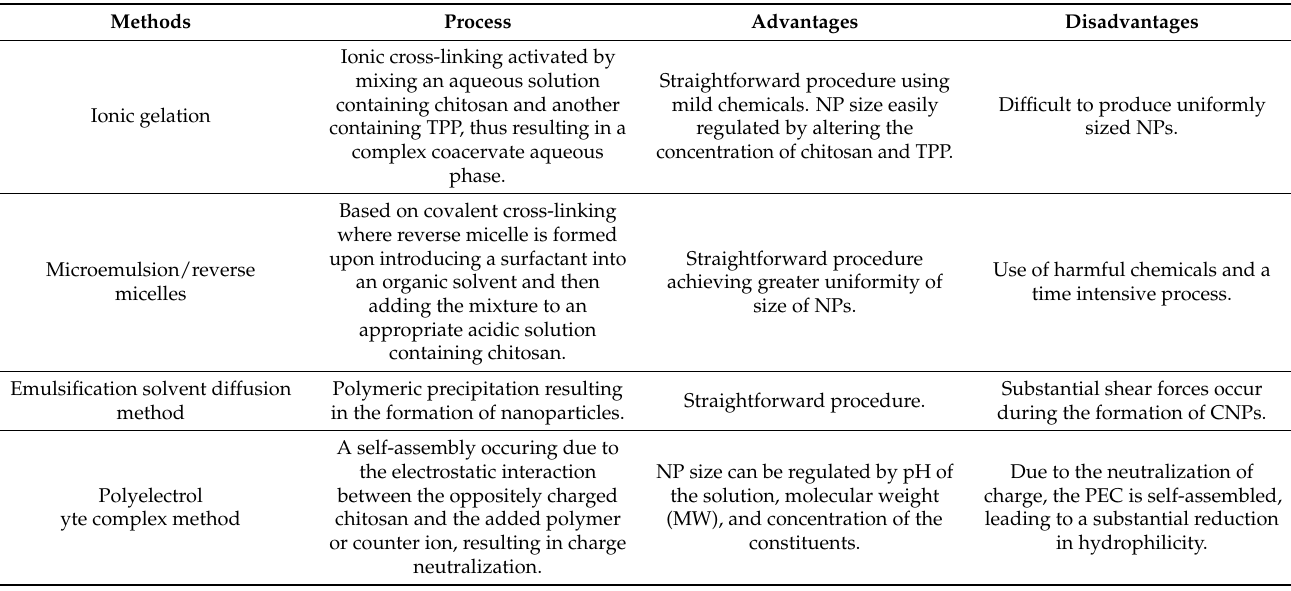
Table 1. Synthesis methods used to make chitosan